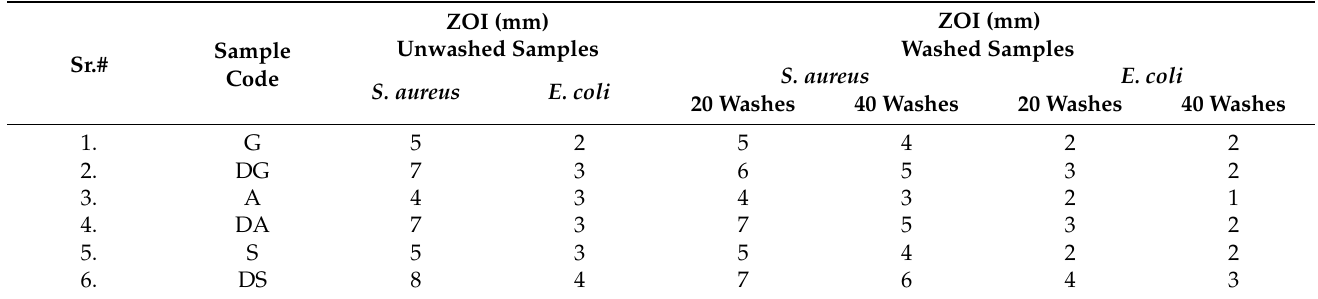
Table 10. Antimicrobial properties of Cu 2 O-coated fabrics after